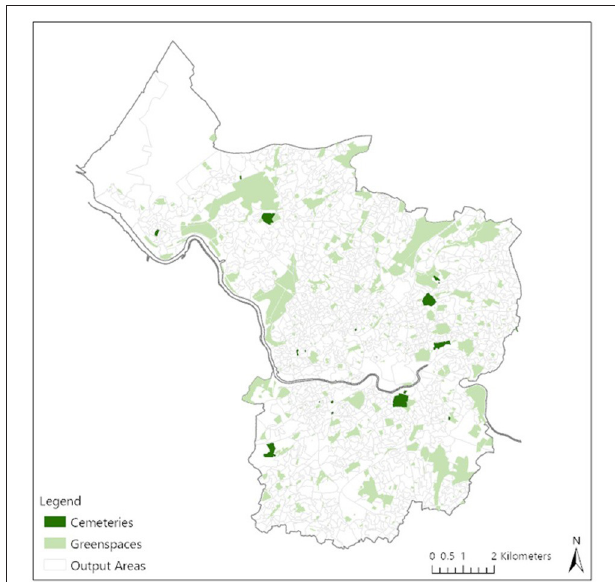
FIGURE 2 | Location of greenspaces and cemeteries in Bristol, UK with cemeteries surveyed in this study labelled (Contains public sector information licenced under the Open Government Licence v3.0; Contains National Statistics data © Crown copyright and database right 2021; Contains OS data © Crown copyright and database right